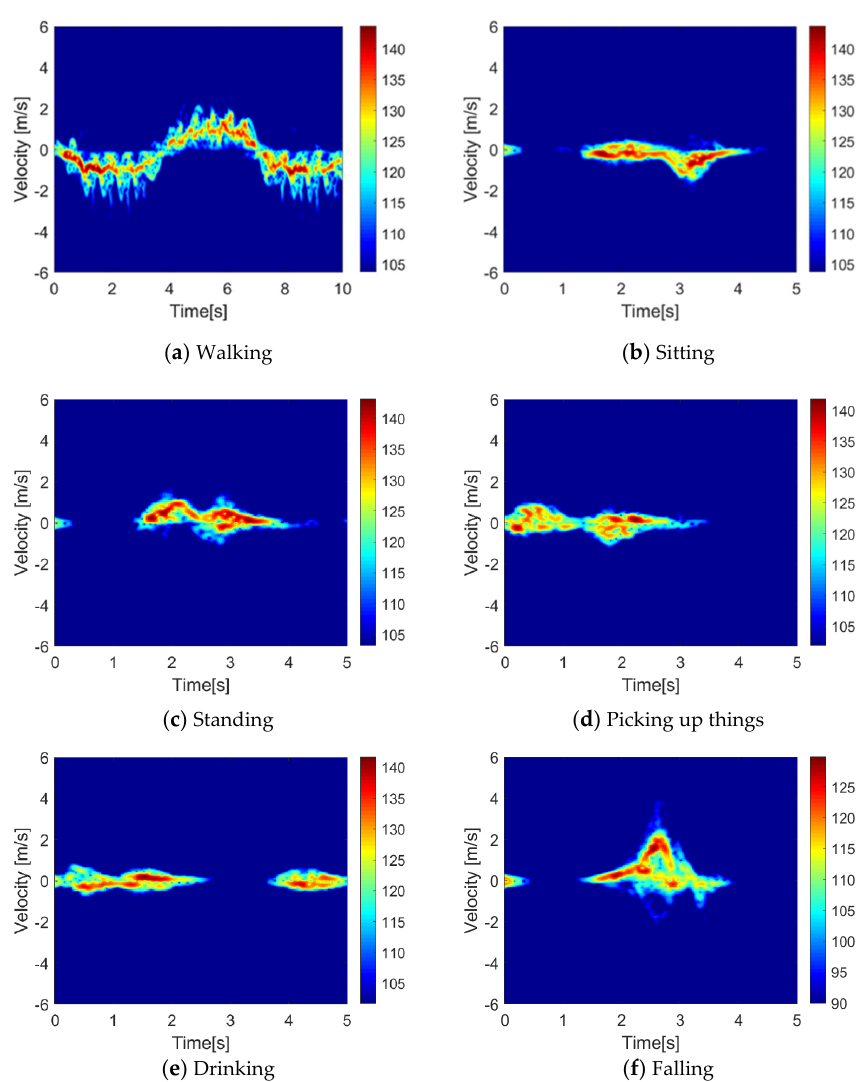
Figure 4. Radar spectrograms of six activities.